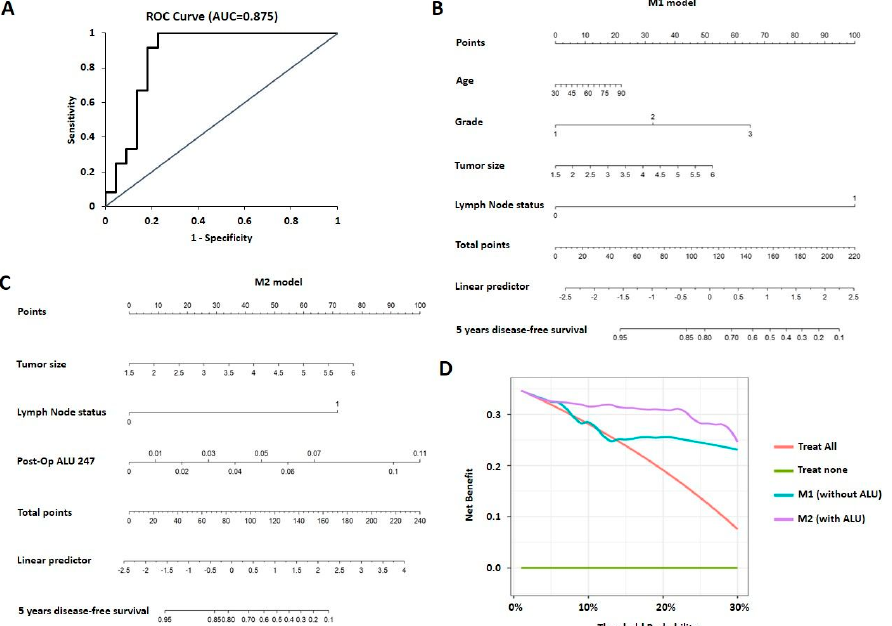
Figure 4. ( A ) ROC curve for ALU 247 with other parameters with AUC analysis derived by logistic regression. ( B ) Nomogram analysis with the M1 model depicting disease-free survival based on conventional parameters. ( C ) Nomogram analysis with the M2 model depicting disease-free survival based on conventional parameters along with post-operative ALU 247 levels. ( D ) Decision curve analysis derived for the nomogram M1 and M2 depicting the net benefit of the model across different threshold probabilities.